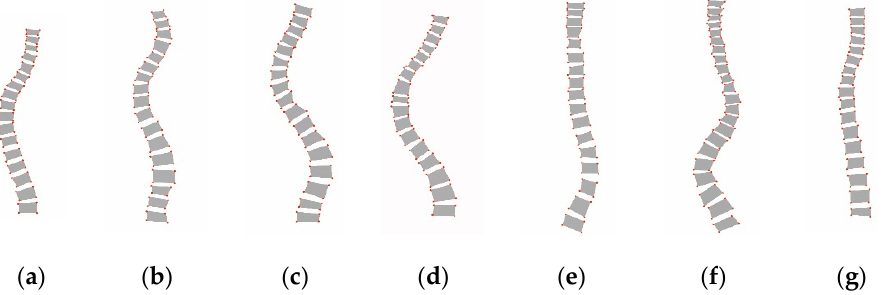
Figure 1. The normal spine and six Lenke types of scoliosis: ( a ) Lenke 1; ( b ) Lenke 2; ( c ) Lenke 3; ( d ) Lenke 4; ( e ) Lenke 5; ( f ) Lenke 6; and ( g ) and ( h ) normal.